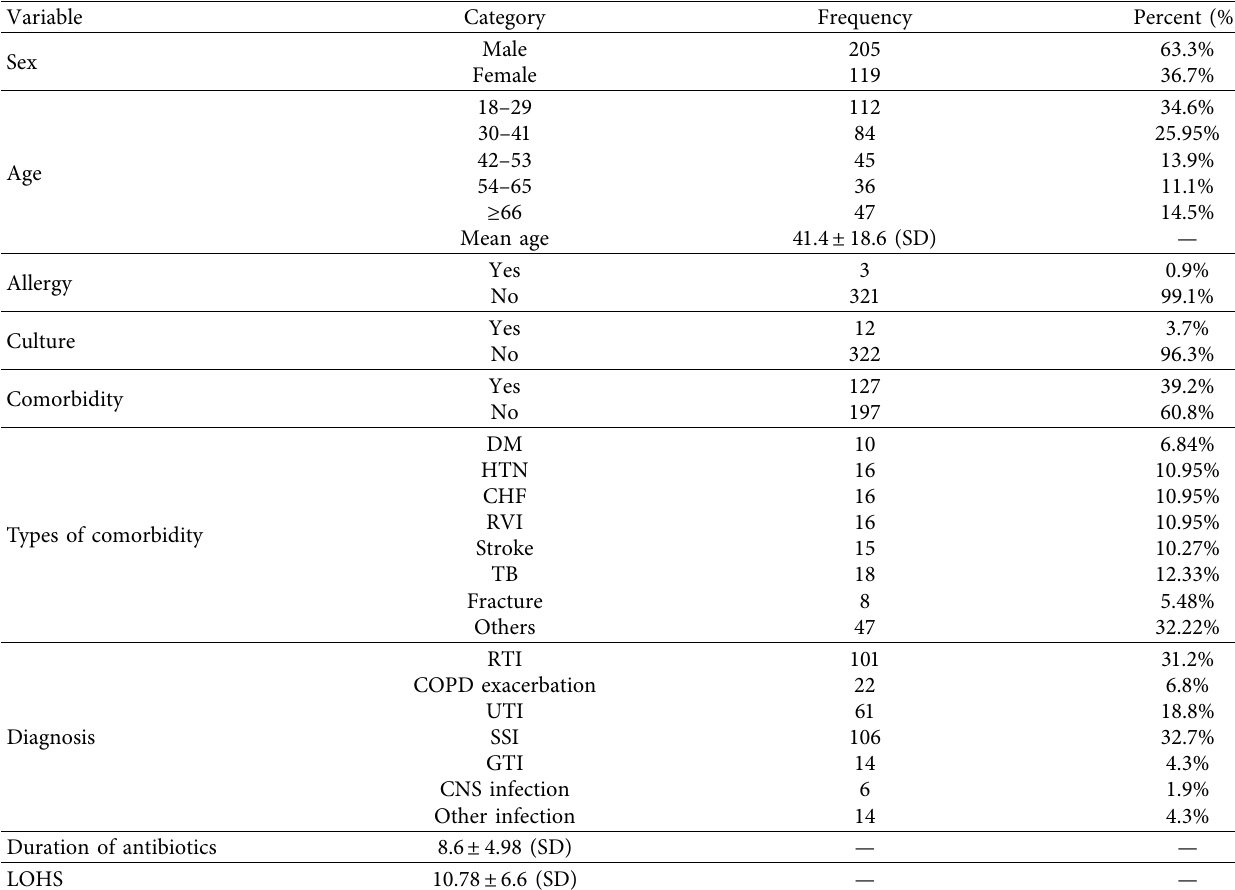
Table 1: Sociodemographic and clinical data of study participants at the University of Gondar Specialized Hospital from October 3 to November 14, 2021 ( n � 324).